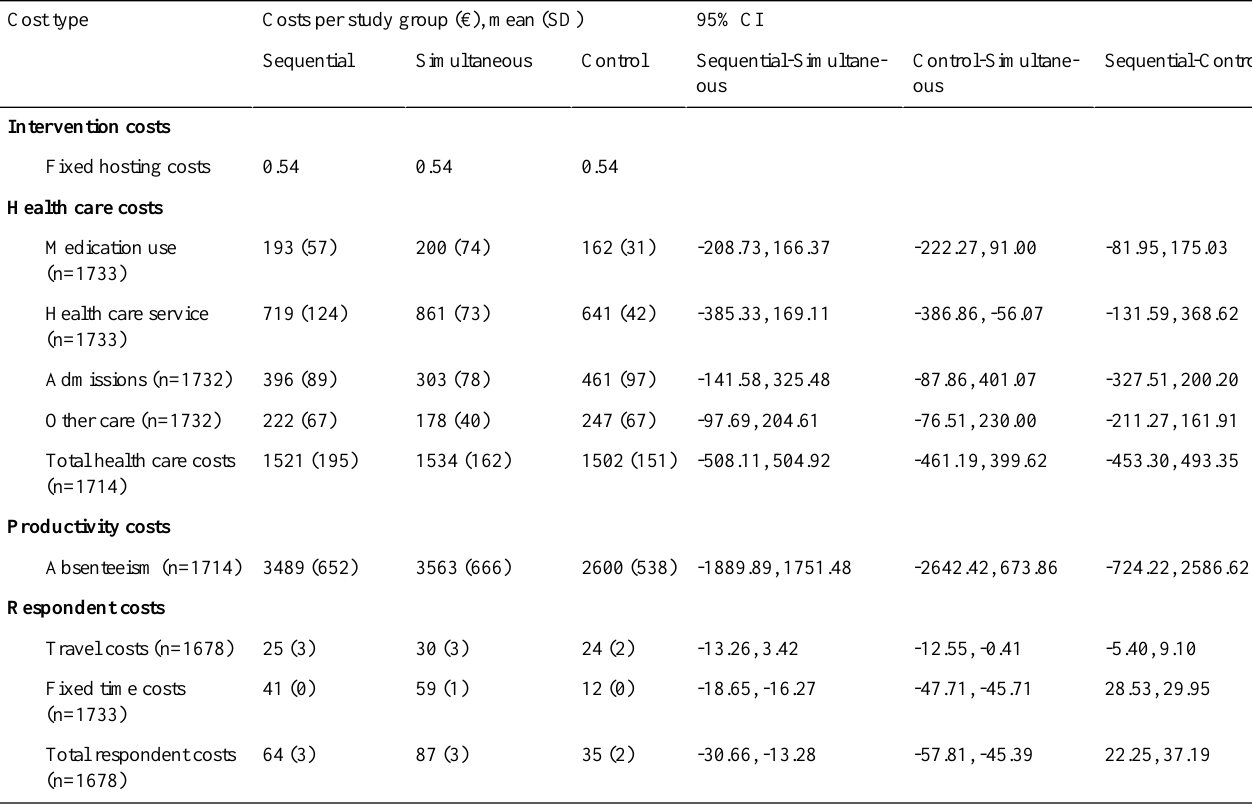
Table 2. Mean biennial costs per participant per study group based on 5000 bootstrap replications.